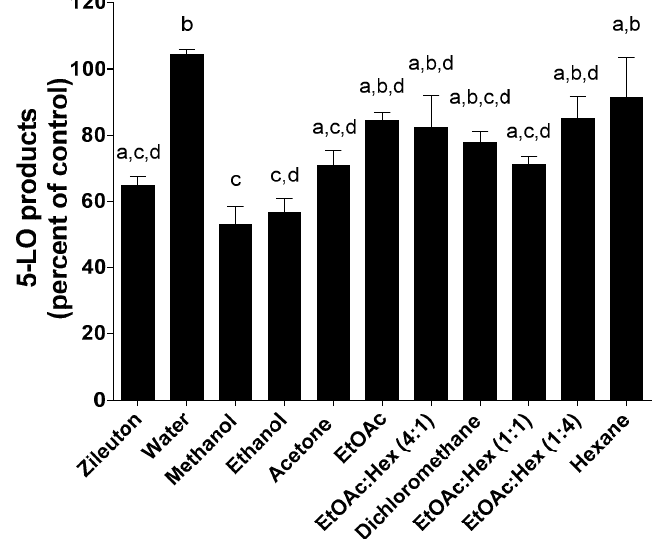
Figure 8. Inhibition of 5-LO product biosynthesis in HEK293 cells by zileuton (1 µM) and all dry extracts (5 µg/mL) following MAE. Values are the means ± SEM of at least three independent experiments, each performed in duplicate; values with different superscripts are significantly different ( p < 0.05) as determined by one-way ANOVA test with subsequent Tukey’s adjustment.